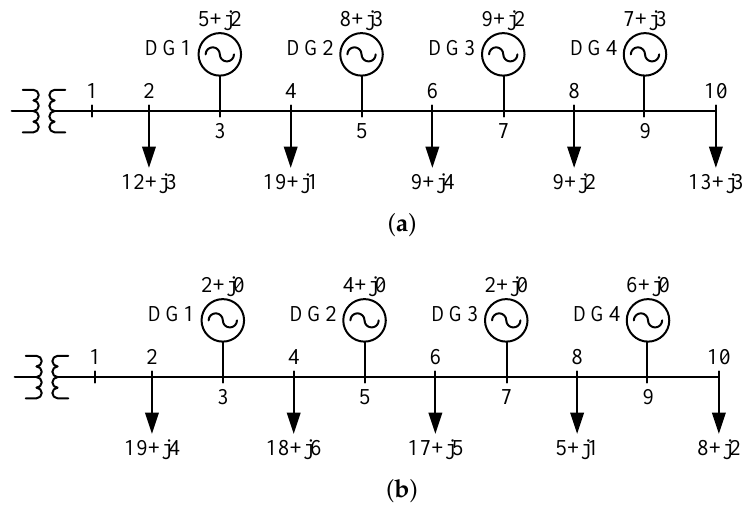
Figure 11. Initial condition of the test system. ( a ) Case 1; ( b ) Case 2.